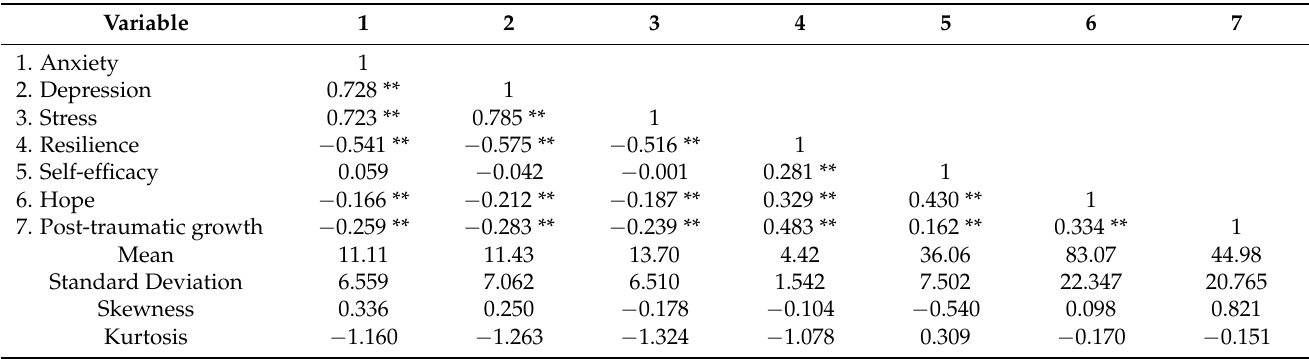
Table 3. Descriptive statistics and Pearson correlation coefficients related to variables.